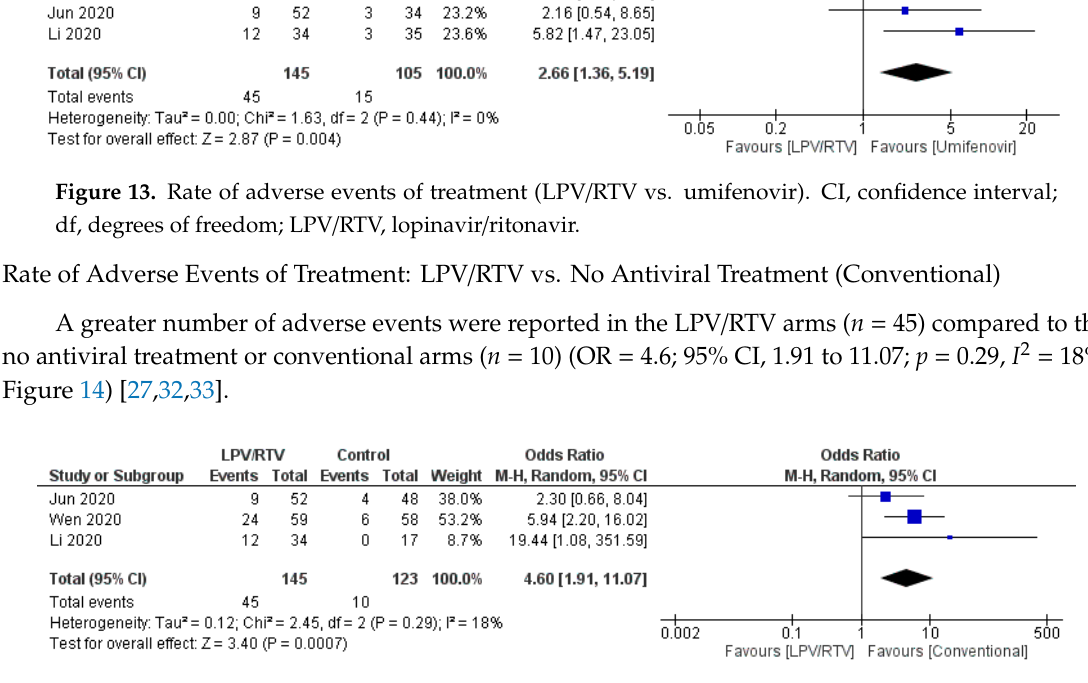
Figure 14. Rate of adverse events of treatment (LPV/RTV vs. no antiviral treatment or